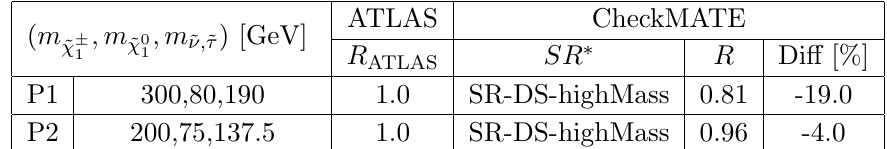
~ (cid:31) (cid:7) production process with the corresponding ATLAS 1 1